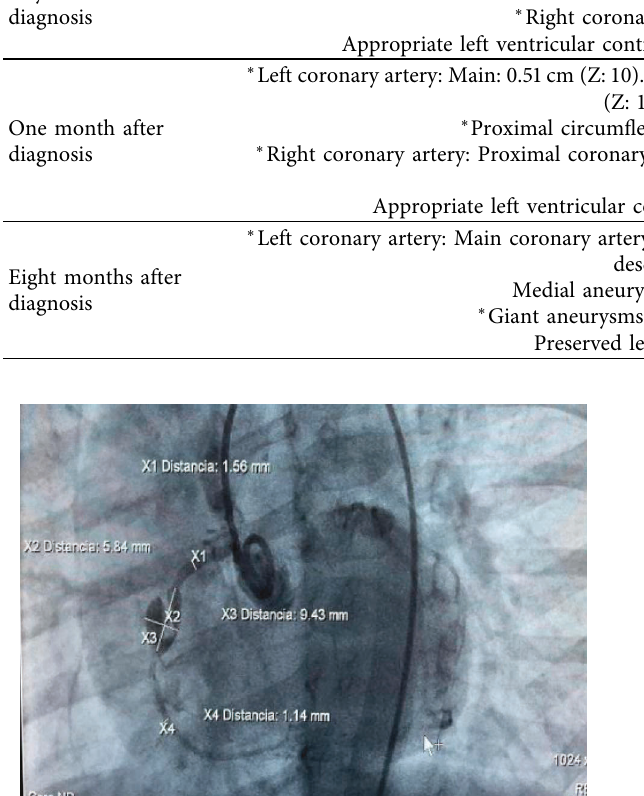
Figure 1: Cardiac catheterization: Aneurysm in the middle third of the right coronary artery, measuring 9.43 mm × 5.8 mm with an image of intracoronary thrombus occupying 2/3 of the aneurysmal lumen.